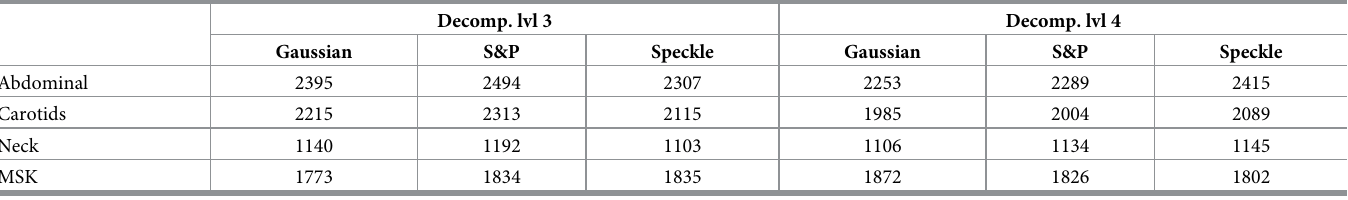
Table 4. The results of computational complexity of Daubechies wavelets for various type of noise and used datasets. Time is in seconds.